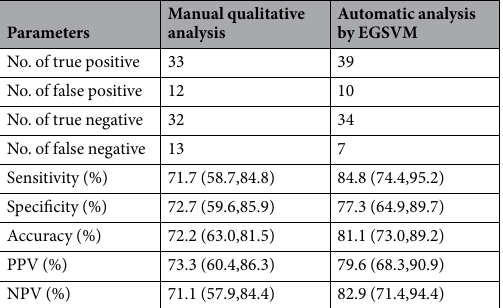
Table 3. Performance of manual and automatic analysis of IR imaging. Data in parentheses are 95% CIs; Sensitivity = true positive/(true positive + false negative); Specificity = true negative/(true negative + false positive); Accuracy = (true positive + true negative)/(true positive + true negative + false positive + false negative); PPV = true positive/(true positive + false positive); NPV = true negative/(true negative + false